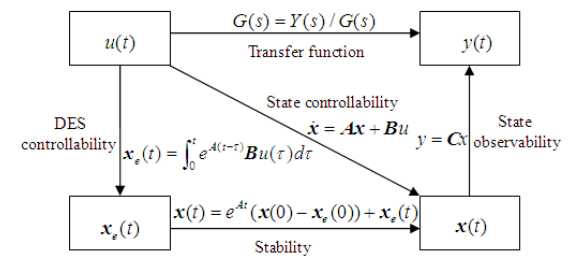
Fig. 1. The relationship between input, DES, state and